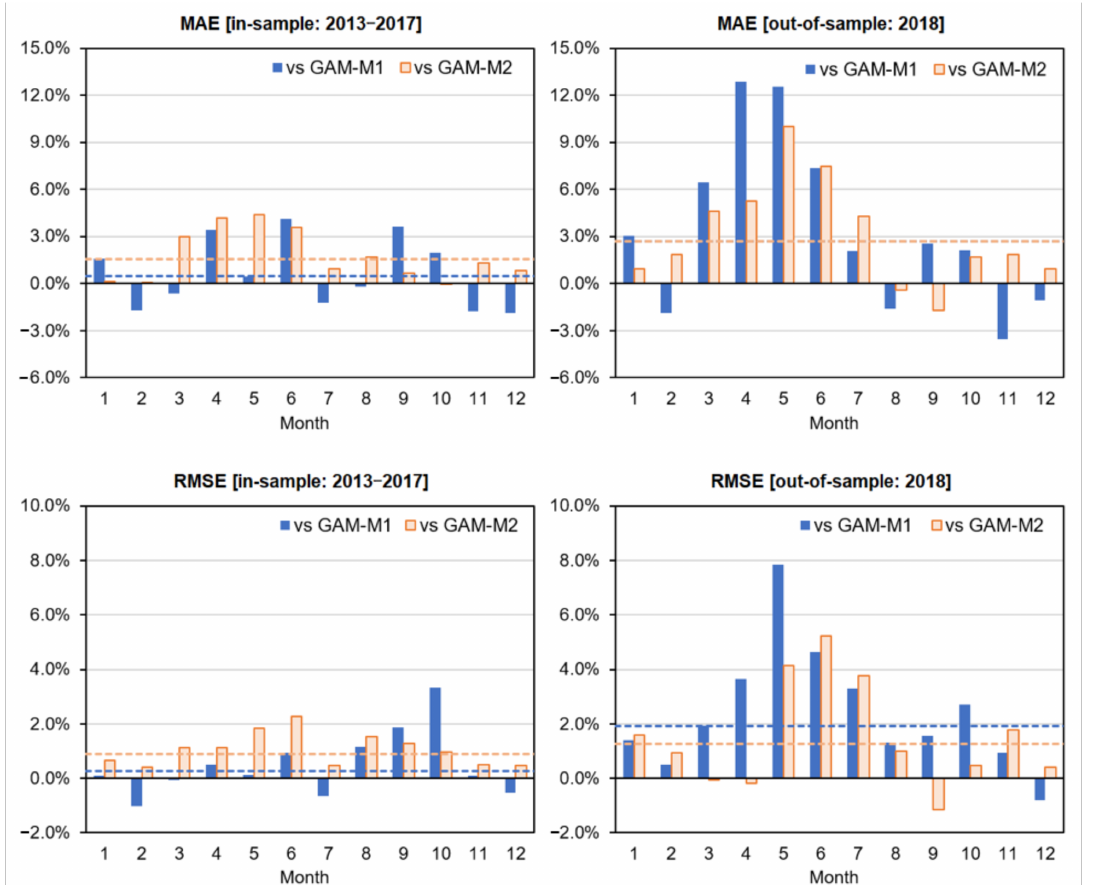
Figure 7. Monthly relative forecast error (MAE and RMSE) of M1 and M2 with respect to M3. Note: The dashed line is the relative increment of the forecast error to M3 over the period (the out-of-sample MAEs overlap the two because they are equal). This is “Default validation case” in Figure 5.